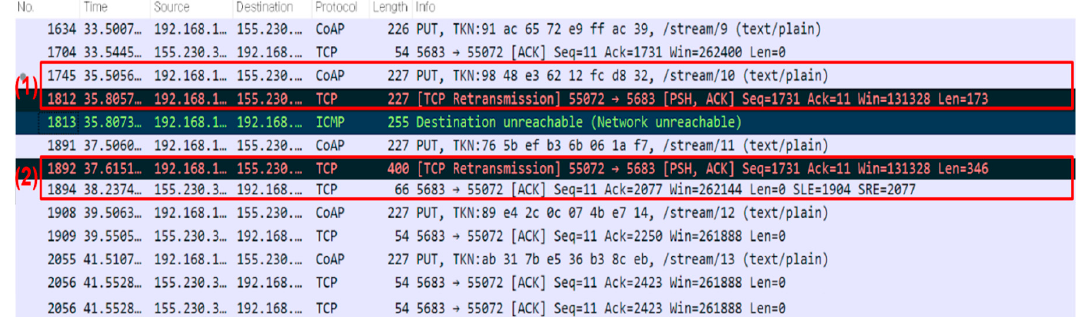
Figure 7. Packet analysis for error handling of CoAP over TCP.